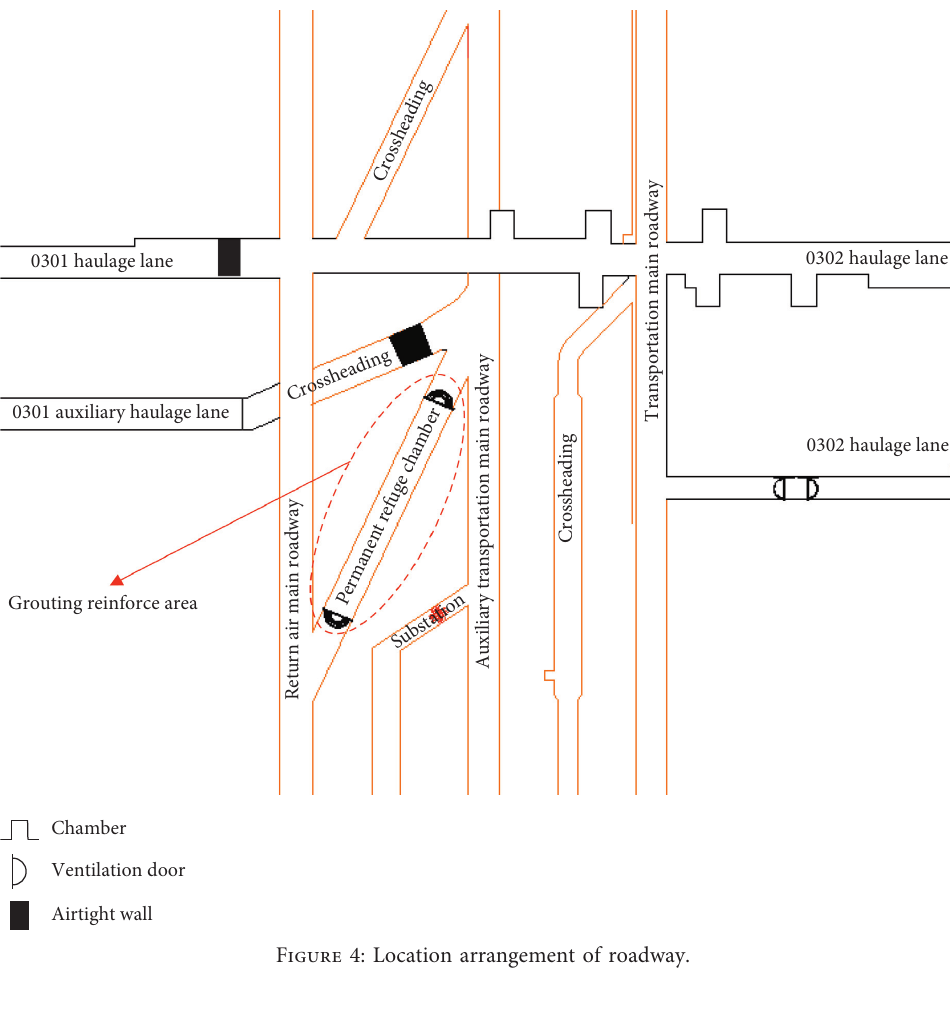
Figure 4: Location arrangement of roadway.